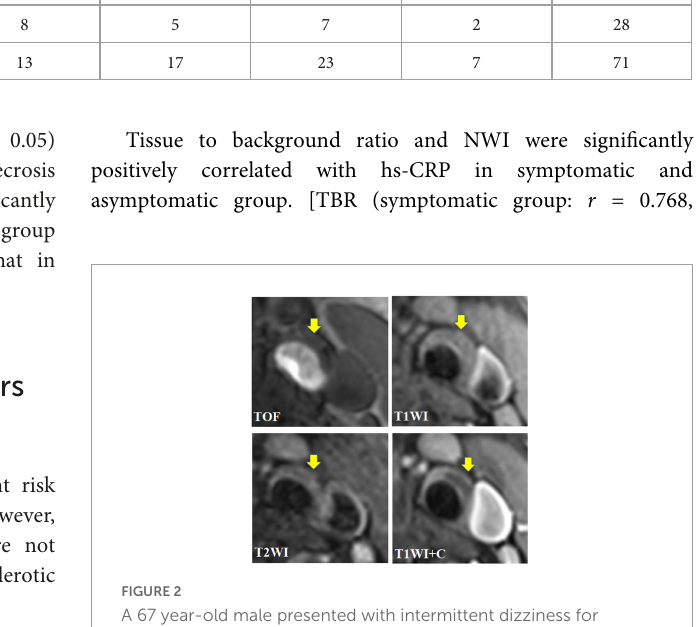
TABLE 3 Distribution of MRI classification of carotid atherosclerotic plaques. Location I-II Common carotid artery